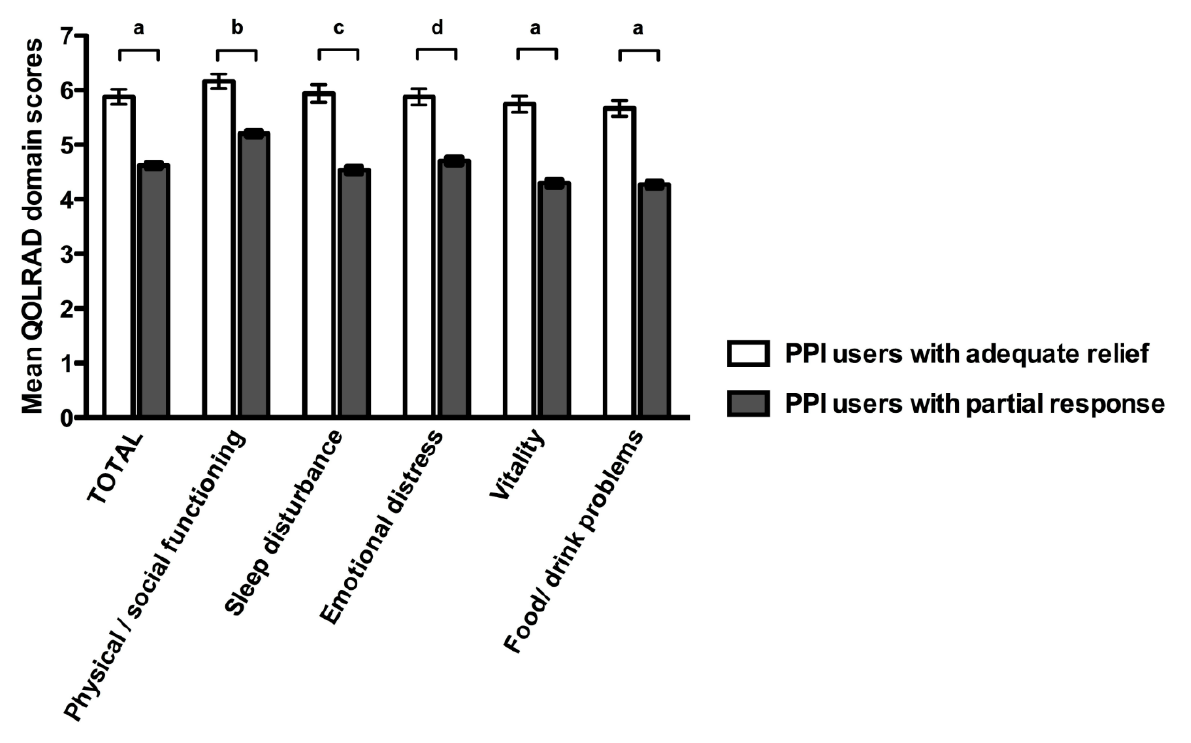
Figure 3. Quality of Life in Reflux and Dyspepsia (QOLRAD) scores by domain in proton pump inhibitor (PPI) users. Error bars indicate SEM. a < .001, b P = .003, c P = .001, d P